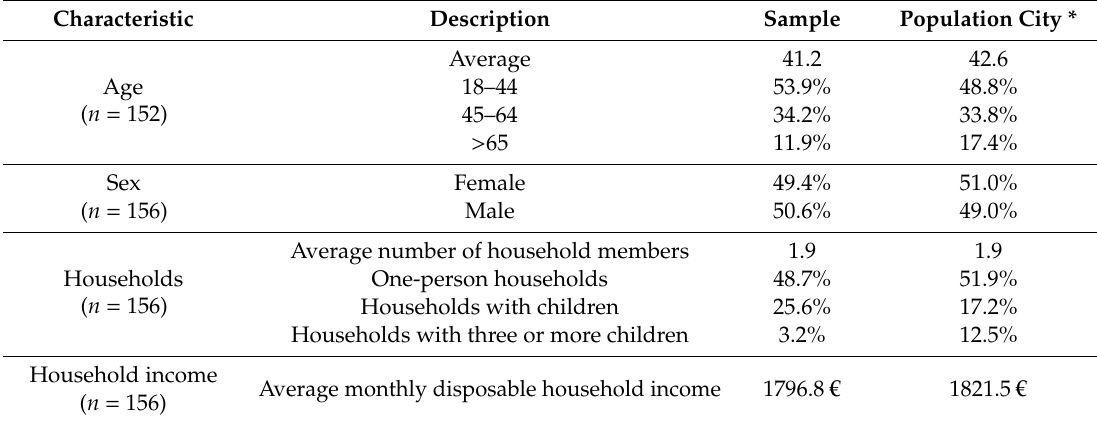
Table 3. Socio-demographic characteristics of the